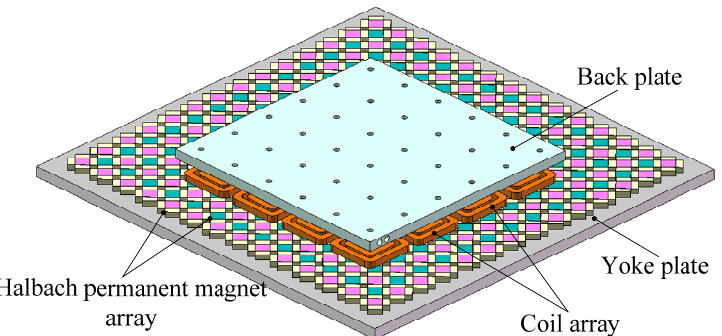
Figure 1. Maglev planar motor structure.